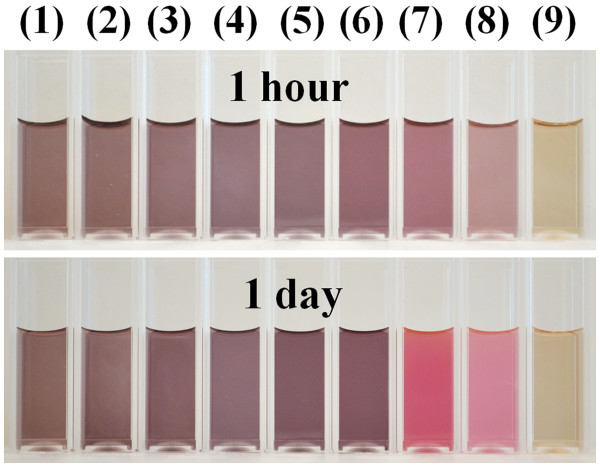
GNP samples after mixing Na
2
S
2
O
3
and HAuCl
4
solutions. The GNP solutions after mixing 2.2, 2.0, 1.8, 1.6, 1.4, 1.2, 1.0, 0.8, and 4.0 mL (samples 1 through 9, respectively) of 3.0 mM Na2S2O3 with 5 mL of 1.71 mM HAuCl4 at 1 h and 1 day, respectively. Photos were taken after the samples were diluted five times with water.